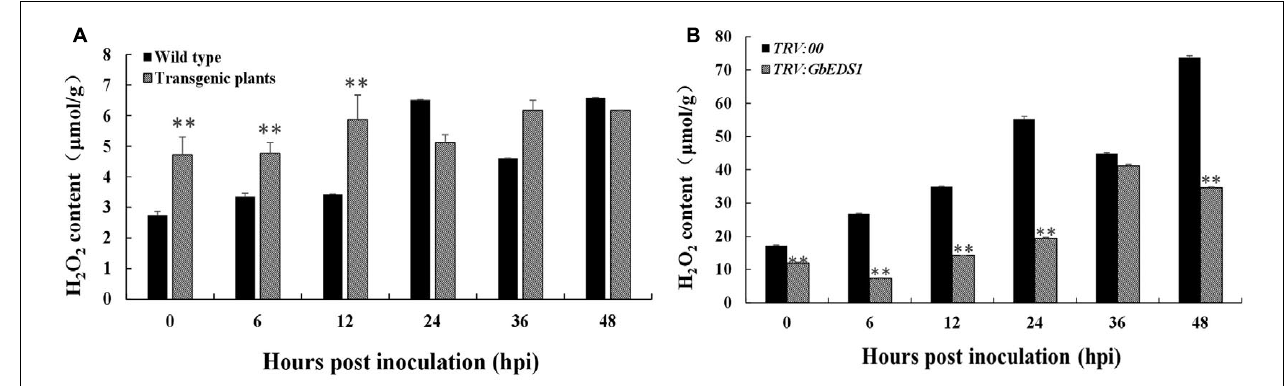
FIGURE 10 | Measurement of H 2 O 2 in response to V. dahliae infection. Detection of H 2 O 2 accumulation in transgenic Arabidopsis (A) and silenced cotton (B) , respectively. Error bars of H 2 O 2 levels represent the standard deviation of three biological replicates; asterisks indicate statistically significant differences, as determined by the Student’s t -test ( ∗∗ P < 0.01).